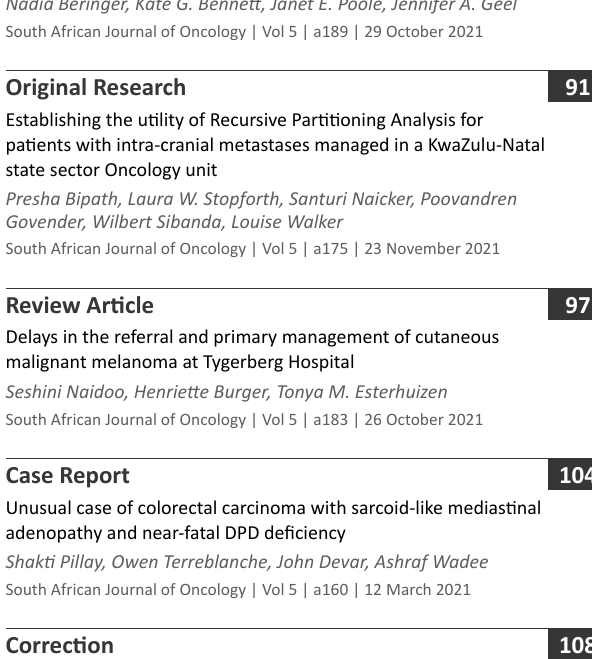
Erratum: Understanding bias in the medical literature: With reflections on metastasectomy